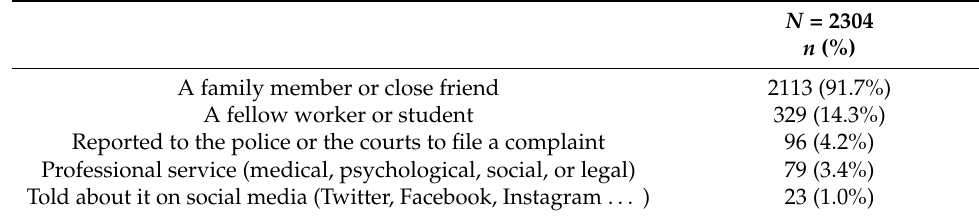
Table 4. Person or institution informed about SH.